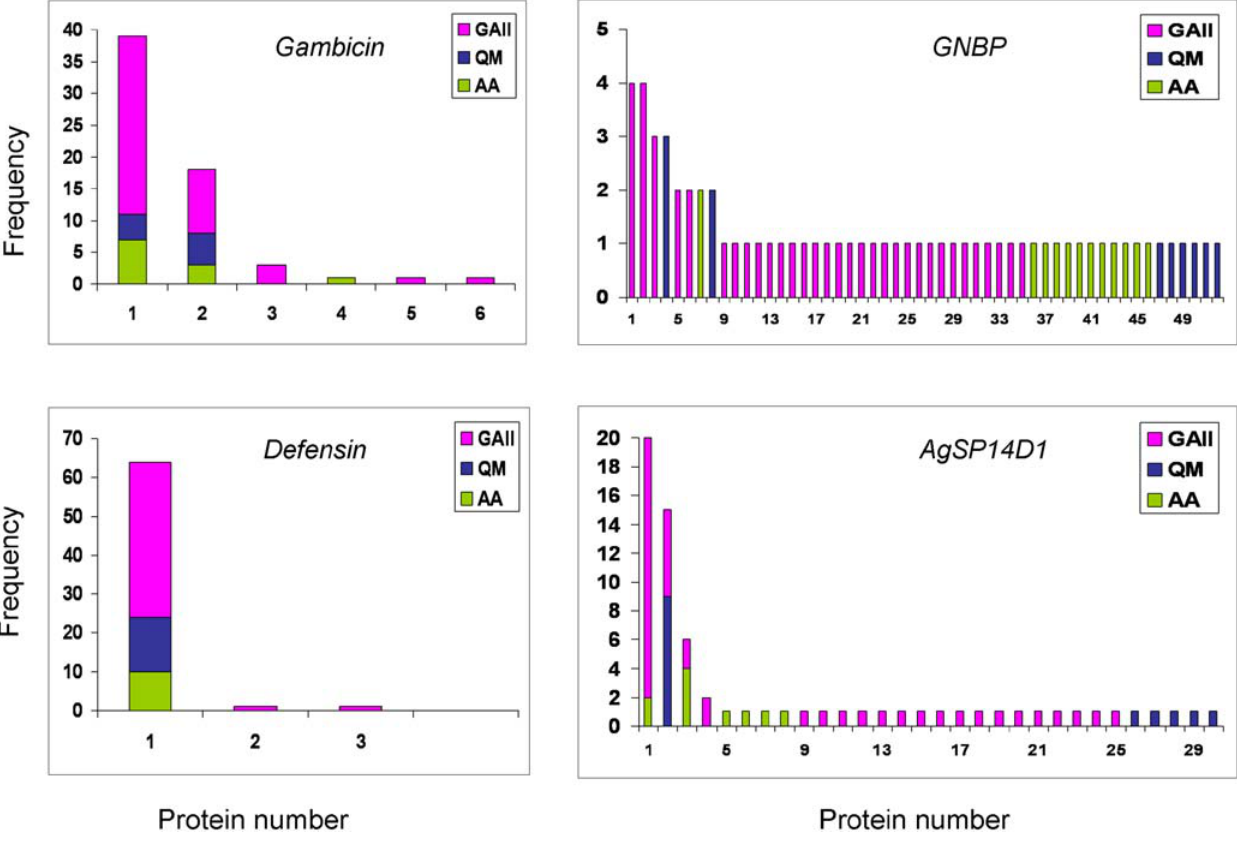
Figure 1. Mature protein (excluding signal peptide and the cleaved propetide segment) distribution within and between species. doi:10.1371/journal.pone.0004549.g001 PLoS ONE |